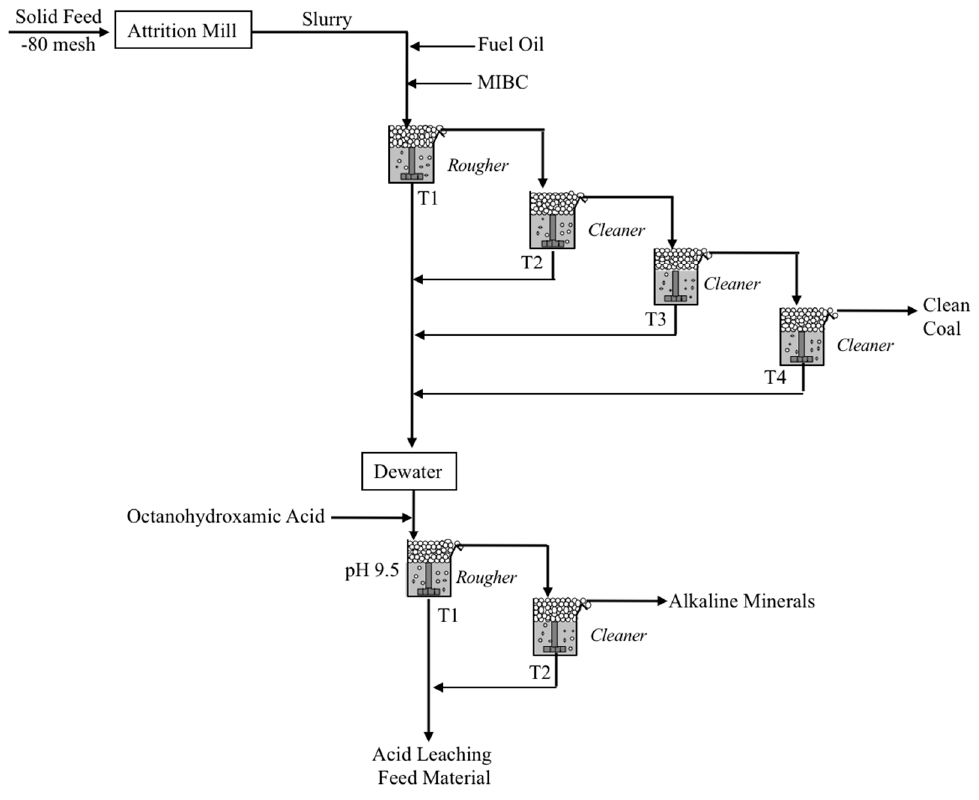
Figure 2. Sample preparation of the Fire Clay middlings for the leaching studies.